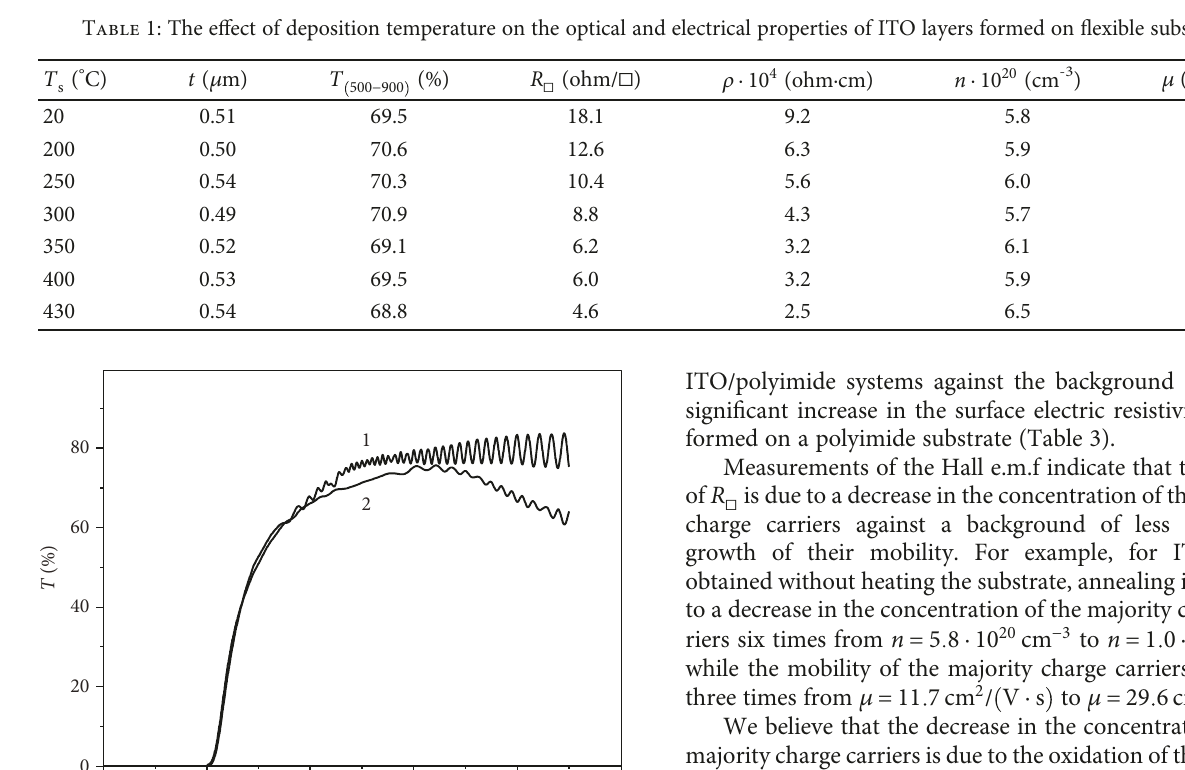
= 1 5Wt/cm 2 , CO = 3Vol % ): (a) Т w